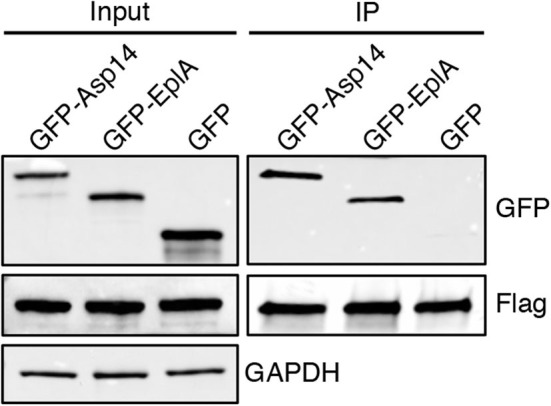
EplA binds PDI. HEK-293T cells were transfected to co-express Flag-PDI and GFP-Asp14, GFP-EplA, or GFP. Input lysates were analyzed by Western blotting with GFP and Flag antibodies to confirm expression of each ectopically expressed protein and with GAPDH antibody to verify that equivalent amounts of protein were in each sample. Flag antibody-conjugated agarose beads were incubated with whole cell lysates to immunoprecipitate (IP) Flag-PDI and its interacting proteins. The resulting Western blots were probed with Flag antibody to confirm that Flag-PDI was recovered and GFP antibody to assess if Flag-PDI co-immunoprecipitated GFP-EplA or GFP. Data are representative of three independent experiments that yielded similar results.